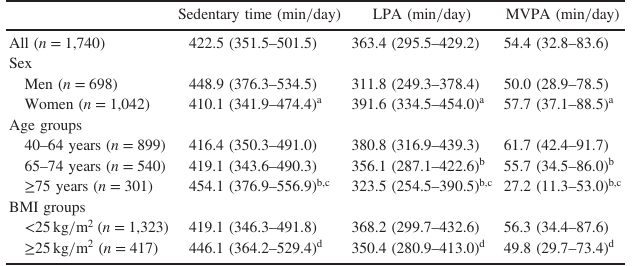
BMI, body mass index; LPA, light physical activity; MVPA, moderate-to- vigorous physical activity.